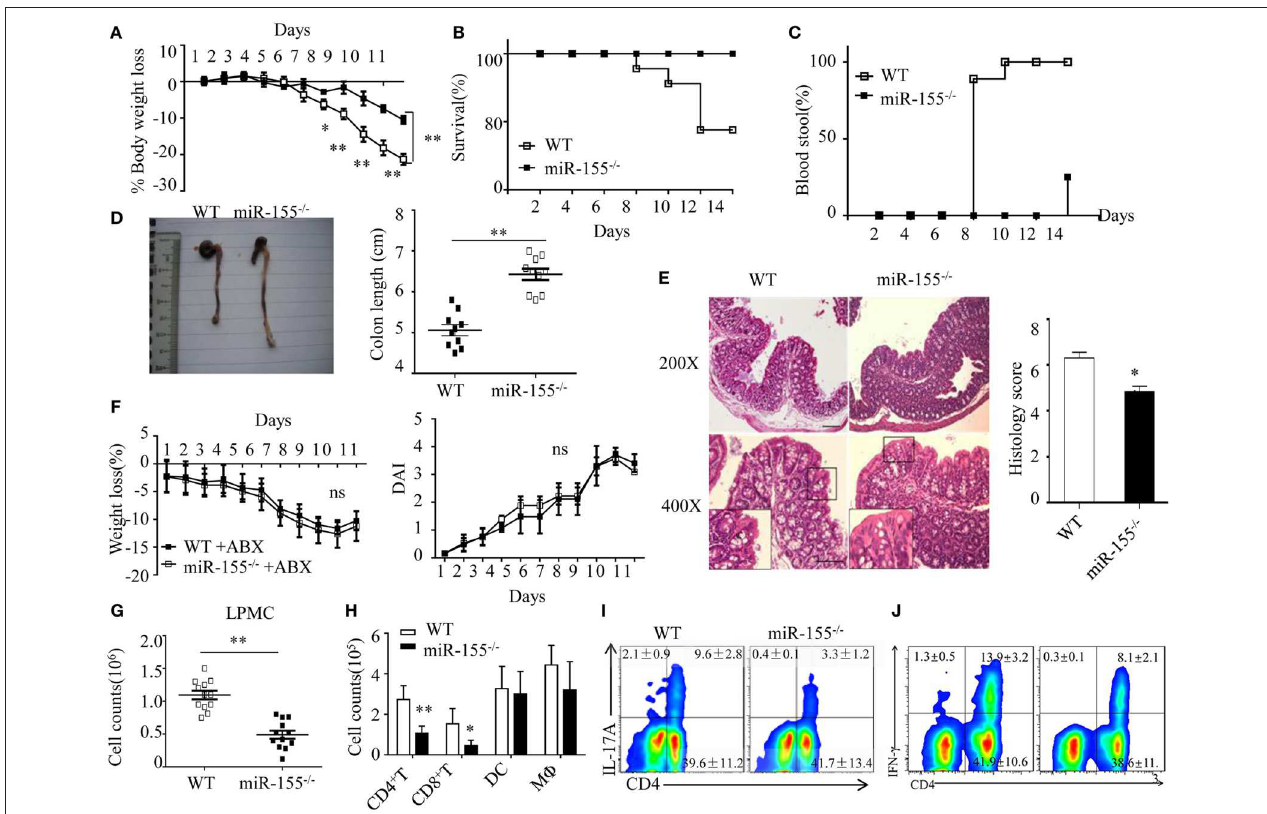
FIGURE 1 | Attenuated dextran sulfate sodium (DSS)-induced colitis in miR-155 − / − mice is dependent on commensal bacteria. WT or miR-155 − / − mice were given 3% DSS in drinking water for 5 days, followed by regular drinking water for 6 days. (A–E) Weight change (A) , Kaplan–Meier plot of survival rate (B) , stool blood (C) , representative gross colon appearance [ (D) left] and colon length [ (D) right], and representative H&E-stained colon cross-sections [ (E) left, original magnification, 200 × or 400 × ] and semi-quantitative histopathology score [ (E) right]. (F) WT and miR-155 − / − mice were treated with broad-spectrum antibiotics cocktail (ABX) for 4 weeks and then given 3% DSS, the body weight change (left) and DAI (right) were monitored daily. Ns vs WT control (G,H) . The LPMCs were isolated from colon tissues of DSS-treated WT ( n = 12) and miR-155 − / − ( n = 15) mice, then the total number of LPMCs (CD45 + ) (G) , T cells (CD4 + and CD8 + ), DCs (CD11c + CD11b − ) and macrophages (CD11b + CD11c − / low ) (H) were counted by flow cytometry. (I,J) Representative FACS showing CD4 + IL-17 + cells (I) and CD4 + IFN- γ + cells (J) in isolated LPMCs of DSS-treated WT ( n = 12) and miR-155 − / − ( n = 15) mice. * P < 0.05,** P < 0.01 vs WT control [Student’s t -test in (A,D,E,G,H) and Kaplan–Meier analysis in (B,C) ]. ns vs WT control. Data are representative of three independent experiments (mean and SD in A-D); n = 12–15 mice per group in (A–F) and n = 5–6 mice per group in (G) . ns, not significant. WT,